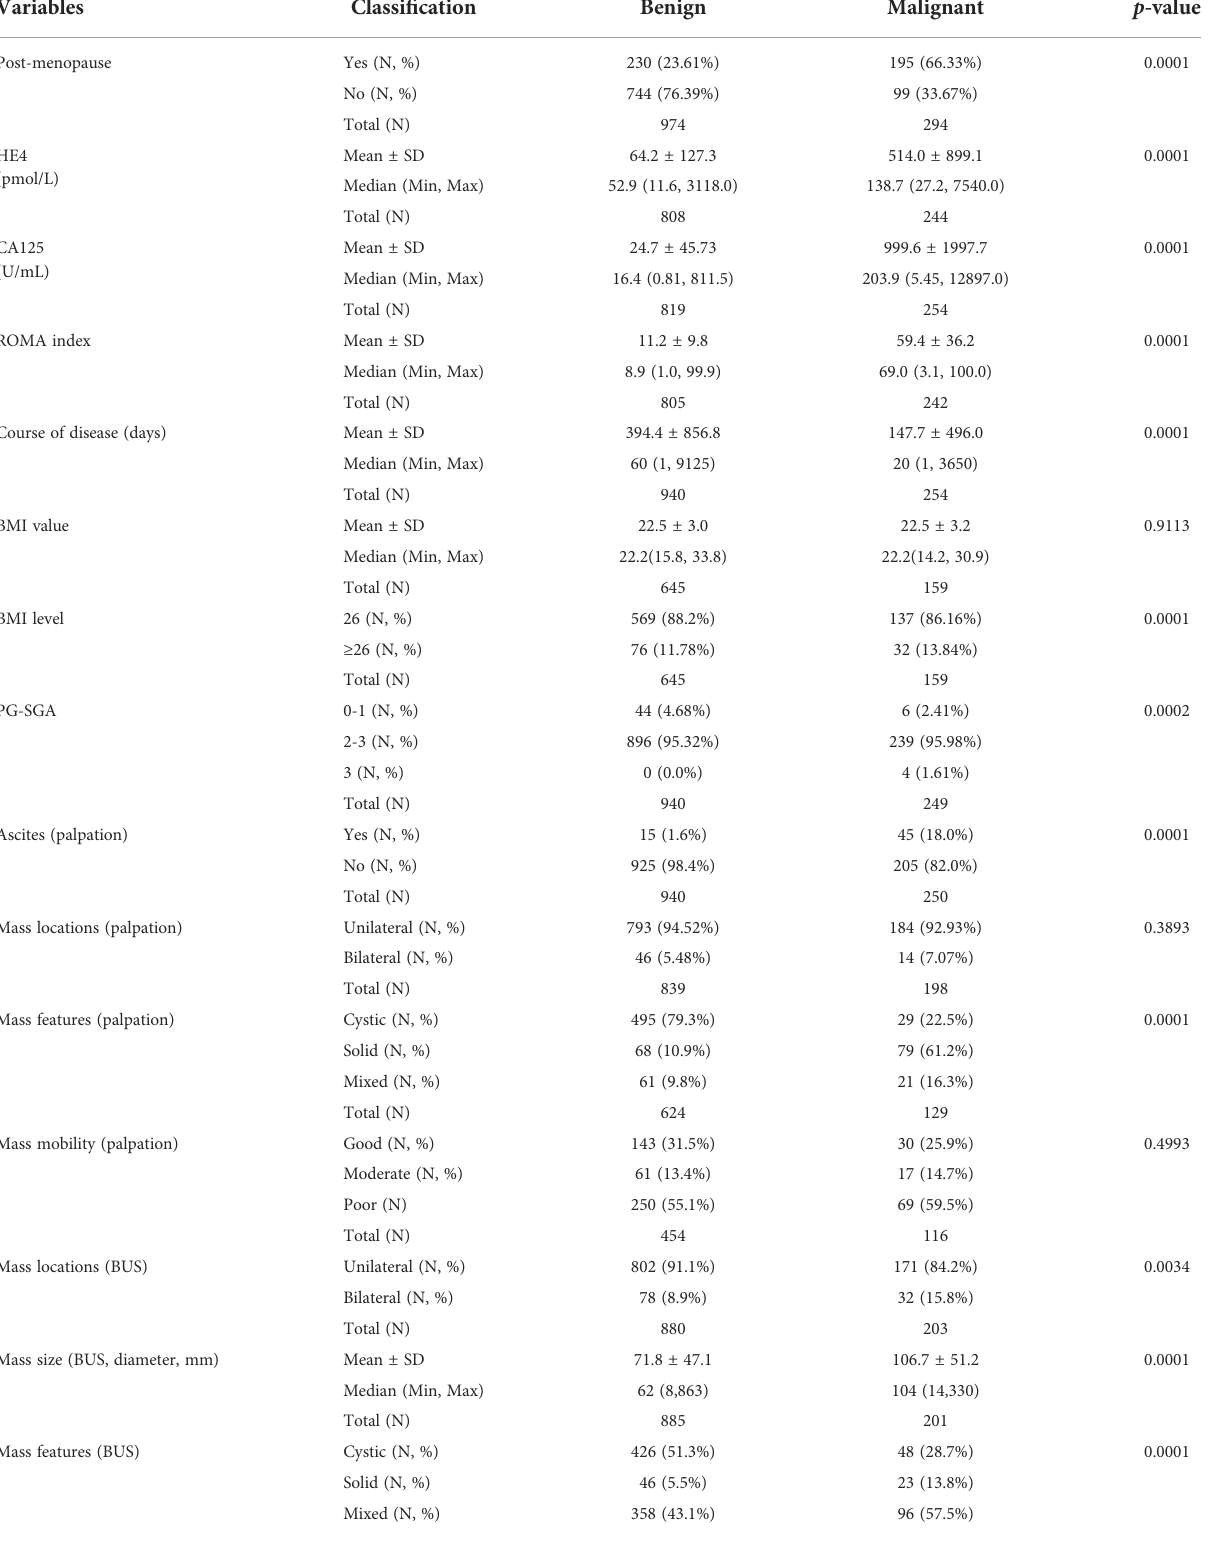
TABLE 1 Characteristics and univariate statistics of benign and malignant ovarian tumor